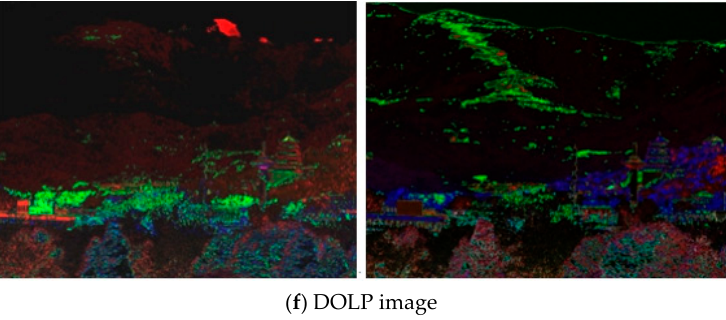
Figure 8. ( a ) The observation geometry of the non-field-axis area. ( b ) The observation geometry of the field-axis area. The imaging device used in the experiment was a polarization spectrum camera. ( c ) The unpolarized image of the field-axis area and the non-field-axis area has high atmospheric visibility. The image is clear whether it is observed in the neutral-point area or the non-neutral-point area. ( d – e ) are the Q component and U component images of ( c ). ( f ) The DOLP image, which takes ( c – e ) as the red (R), green (G), and blue (B) bands, respectively. Figure 9 shows the effect of different BPDF (Bidirectional Polarization Distribution Function) models on TOA (Top of Atmosphere) polarized reflectance under different aer- osol optical depth conditions. The first column is the comparison between the simulated and observed surface polarized reflectance. The second column is the comparison be- tween the modeled and the observed TOA polarized reflectance under Rayleigh condi- tions. The last three columns are the comparison between the modeled and the observed TOA polarized reflectance under different aerosol optical depths ranging from 0.1 to 0.5. The correlation coefficient and RMSE × 100 are displayed in the upper left corner of each sub-figure.